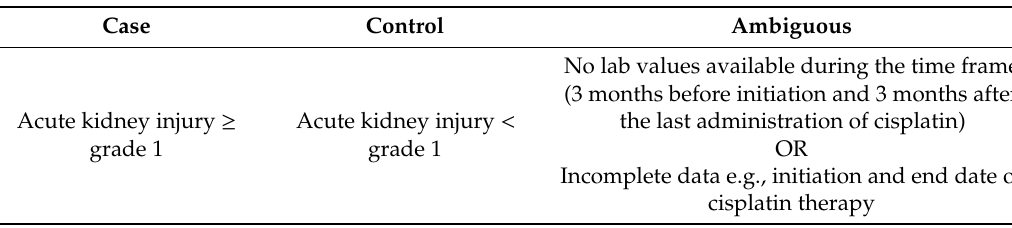
Table 3. Case-control designation according to Common Terminology Criteria for Adverse Events (CTCAE)-AKI Outcome